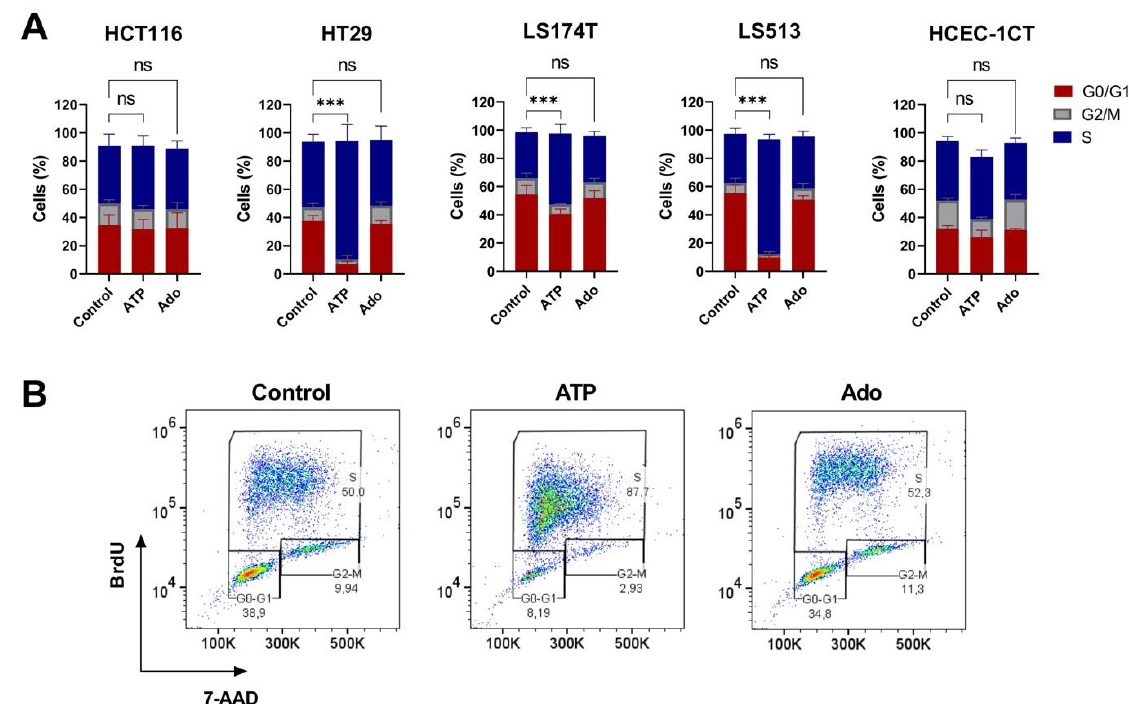
Figure 5. Cell cycle modulation in CRC cell lines induced by purine molecules. ( A ) CRC (HCT116, HT29, LS174T, LS513) and normal-like colonic (HCEC- 1CT) cell lines were left untreated (Control) or incubated with 250 μM of either ATP or adenosine (Ado) for 24 h. Prior to flow cytometry analysis and 7-AAD labeling (DNA), living cells were pulse labeled with BrdU. The percentage of cells in the G0/G1, S and G2/M phases was quantified and expressed as a plot. Data are expressed as the mean +/- SD ( n = 5); p- values were calculated using Student ’s paired t-test (* p < 0.05; ** p < 0.01; *** p < 0.001). ( B ) Representative flow cytometry diagrams for HT29 cells treated or not treated (control) with 250 µM of either ATP or adenosine (Ado). Percentages refer to HT29 cells in G0/G1, S or G2/M.